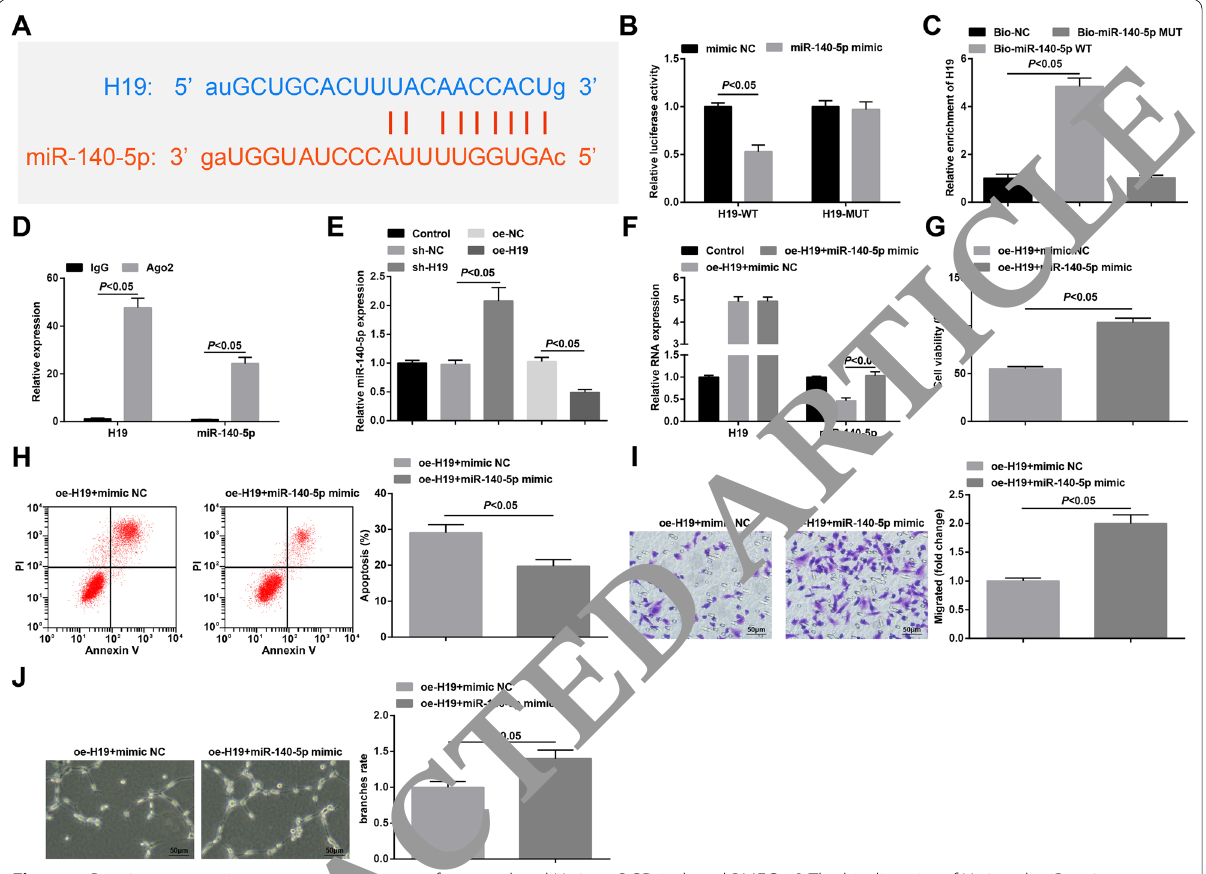
Fig. 4 miR-140-5p restoration negates the impacts of up-regulated H19 on OGD-induced BMECs. A The binding site of H19 and miR-140-5p detected by bioinformatics website; B The binding relationship verified by dual luciferase report gene assay; C The binding relationship between H19 and miR-140-5p detected by RNA pull-down assay; D The enrichment level of H19 and miR-140-5p detected by RIP assay; E , F miR-140-5p expression in oe-H19- and miR-140-5p-mimic-transfected and OGD-induced BMECs detected by RT-qPCR; G Viability of oe-H19- and miR-140-5p-mimic-transfected and OGD-induced BMECs detected by MTT assay; H Cell apoptosis of oe-H19- and miR-140-5p-mimic-transfected and OGD-induced BMECs detected by flow cytometry; I Cell migration of oe-H19- and miR-140-5p-mimic-transfected and OGD-induced BMECs detected by Transwell assay; J Angiogenesis of oe-H19- and miR-140-5p-mimic-transfected and OGD-induced BMECs detected by Matrigel method; N 3. The data were expressed as mean standard = ±